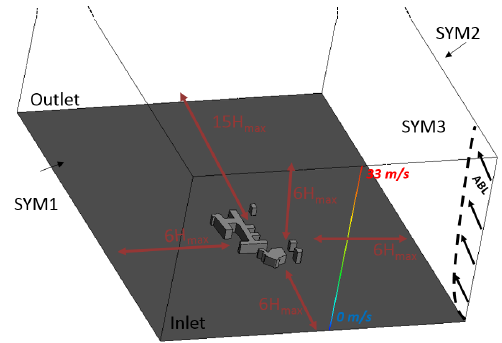
Figure 4. CFD simulation domain. Velocity on vertical line: ABL at inlet. plane or terrain) to obtain the simulation domain for the CFD simulation. The wind is triggered by the atmospheric boundary layer (ABL - a velocity profile with a parabolic shape, (Tominaga et al., 2008)) as plotted in figure 4 (velocity shown as colored and black dashed lines at the inlet of the domain). To resolve turbulent air flow near building walls (e.g. Sachs (1978)) the Reynolds Averaged Navier Stokes equations (RANS; compare Franke et al. (2007)) are solved within each cell depend- ing on its neighboring cells.